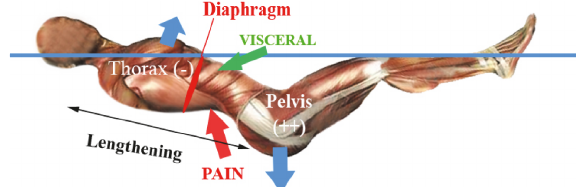
Figure 8: Explicative schematic representation of uncomfortable position in dry immersion (lengthening of spine, visceral mass under diaphragm muscle, and preferential pain in thoracolumbar region) (Published in Treffel et al., 2016